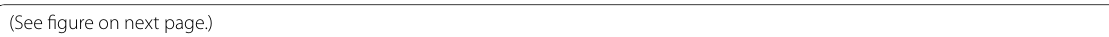
figure on next Fig. 1 The phylogenetic tree construction of fatty acid desaturases genes. A Neighbor-Joining (NJ) phylogenetic tree of all detected fatty acid desaturases genes was constructed, using MEGA 5.0 program with bootstrap analysis (1000 replicates). Fatty acid desaturases genes in the phylogenetic tree were clustered into five distinct groups (groups I-A, I-B, II-A, II-B-1 and